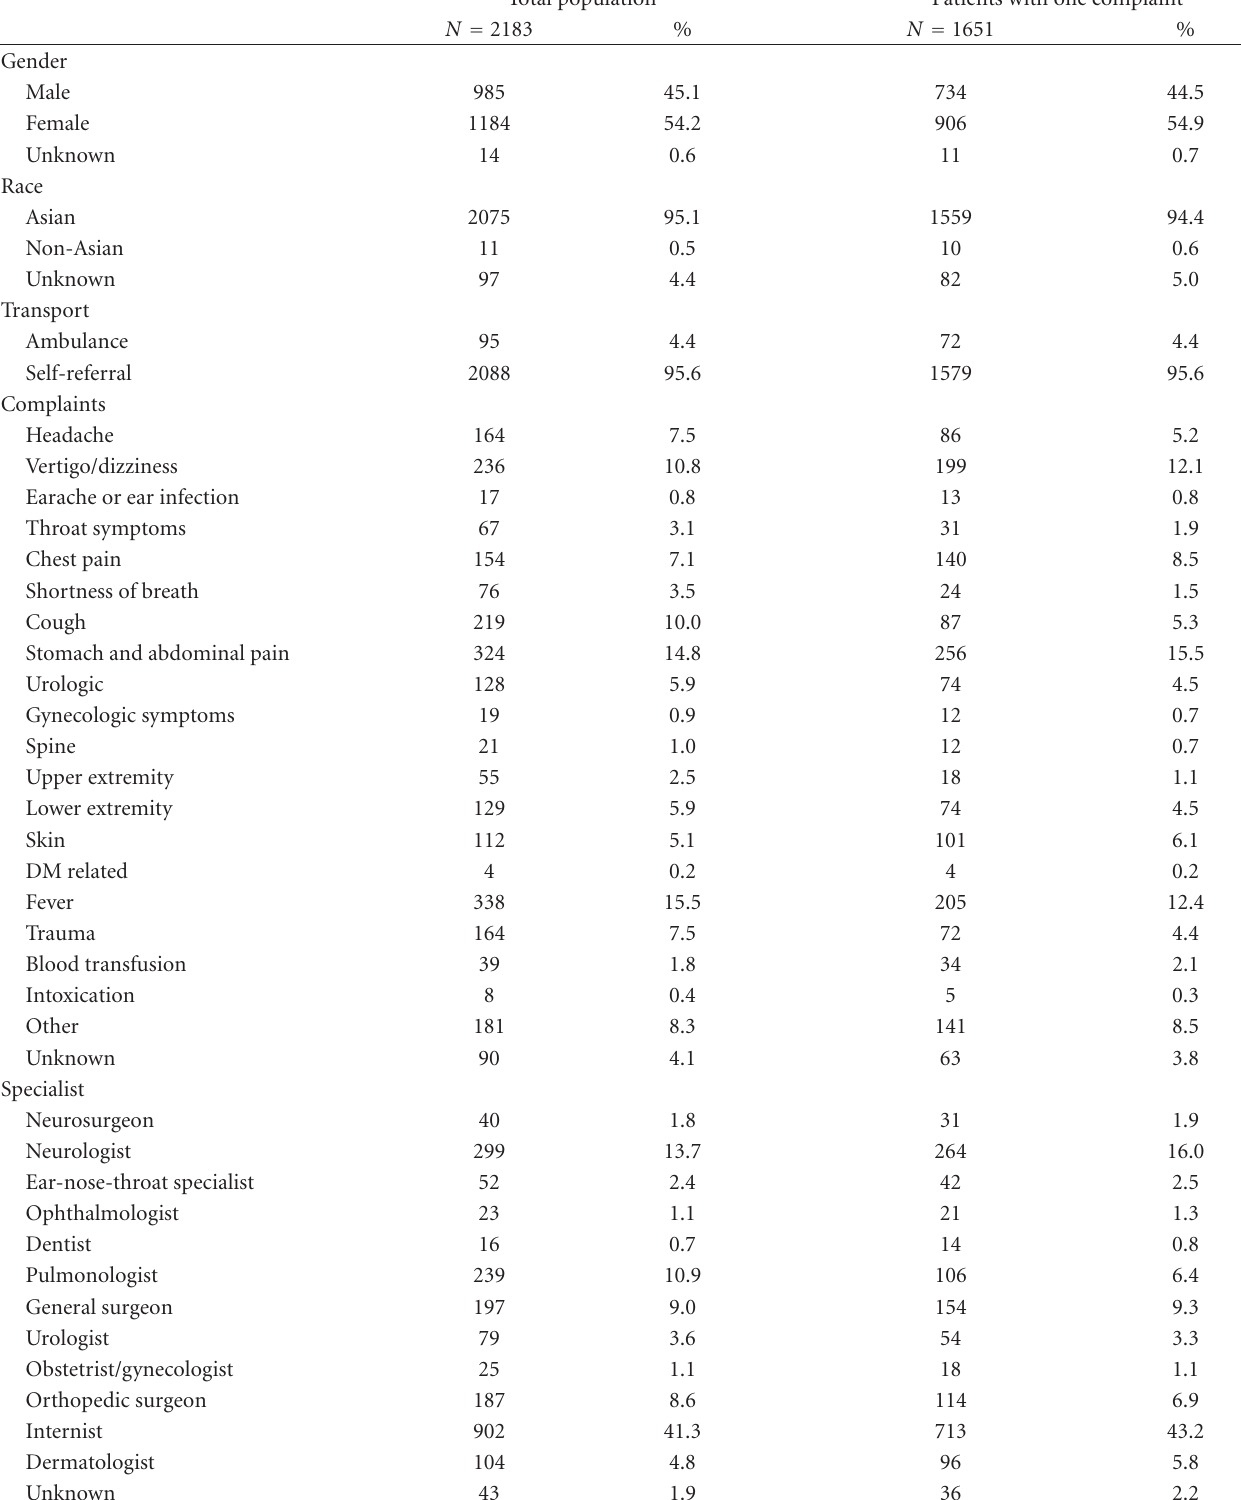
Table 1: Demographic description of patients reporting to the Triage